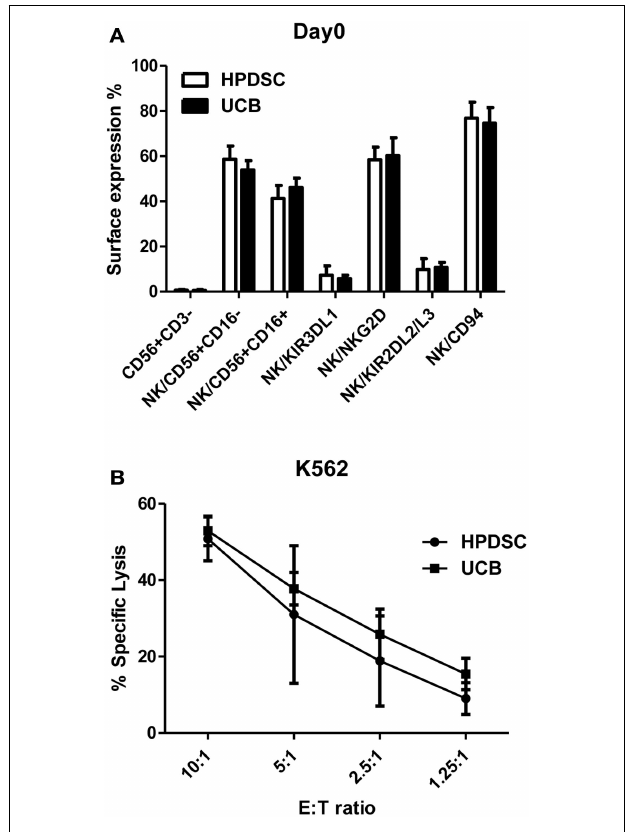
FIGURE 1 | Comparison of NK cells from donor-matched HPDSC and UCB units . (A) Immunophenotypic characterization of NK cells from donor-matched HPDSC and UCB units, the two-sample t -test was used to determine if population means are equal in HPDSC and UCB. (B) Cytotoxicity of expanded NK cells from donor-matched HPDSC and UCB units against K562 cells.